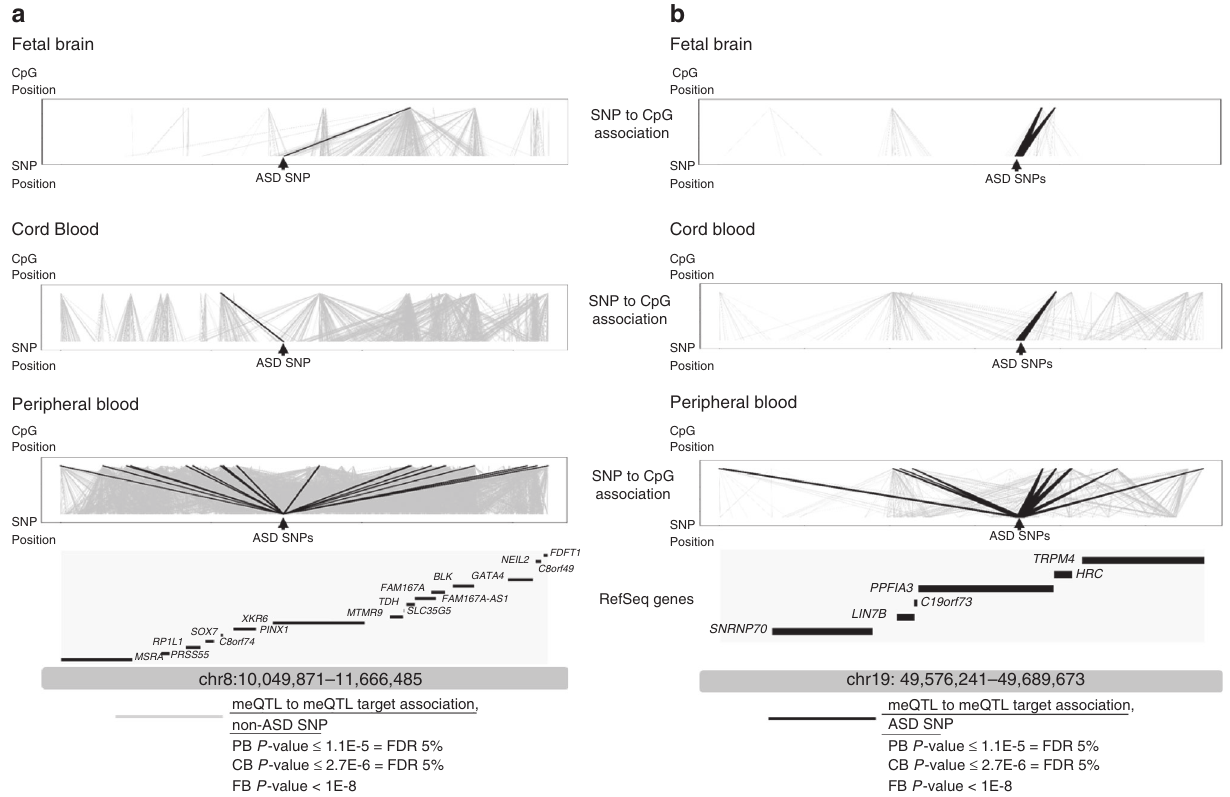
Fig. 1 ‘ Expansion ’ of ASD loci through meQTL mapping in peripheral blood, cord blood, and fetal brain. Each tissue-speci fi c panel presents, from bottom to top: genomic location, gene annotations, SNP locations, SNP – CpG associations, CpG locations. Light gray meQTL association lines denote all SNP to CpG associations in that tissue type; Dark meQTL association lines denote SNP – CpG associations for ASD-associated SNPs in PGC ( P value < = 1e – 04). a Locus at chr8; b Locus at chr19. Data are presented for meQTL maps for fetal brain ( top ); cord blood meQTLs ( middle ), and peripheral blood meQTLs ( bottom